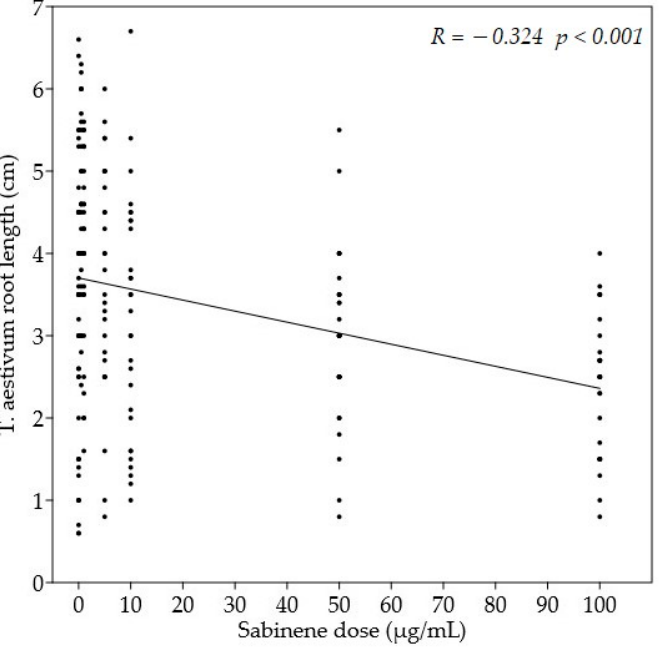
Figure 4. Simple linear regression between sabinene dose (µg/mL) and T. aestivum root length (cm).